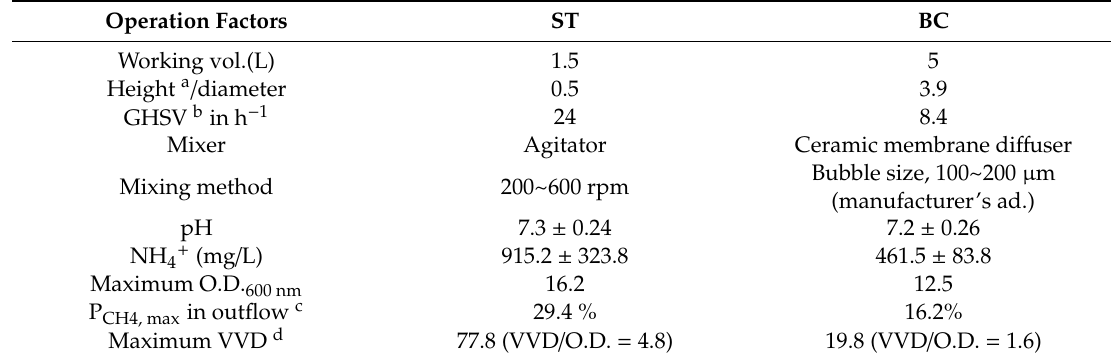
Figure 4. Comparison of the methane production rate with previous reports [9, 31]. The methane production rate (* VVD, volume of methane per volume of reactor per day) as a function of gas hourly space velocity (GHSV). Table 1. Comparison of operation parameters and biomethanation process between the -ST and BC